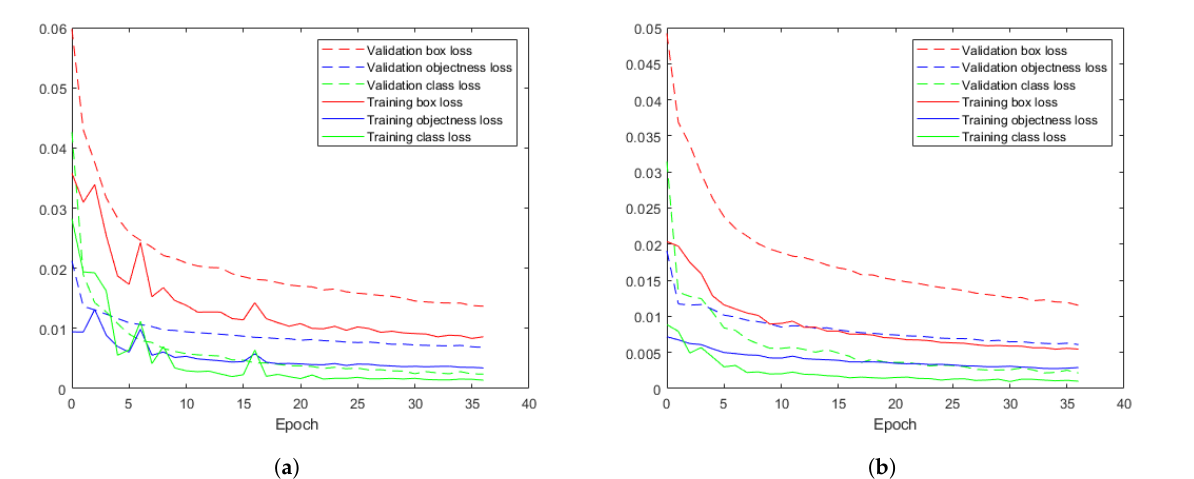
Figure 11. Comparing training versus validation losses: ( a ) small model; ( b ) xlarge